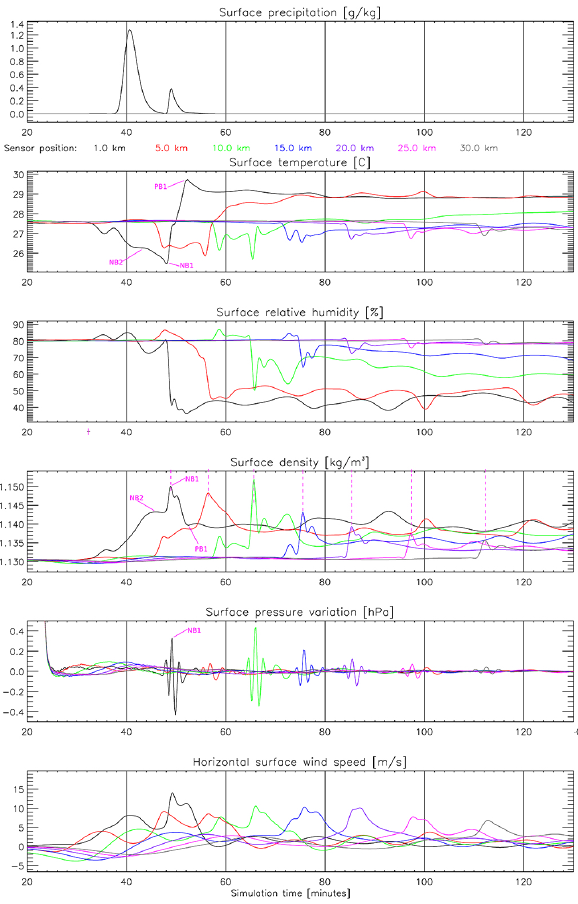
Fig. 4. Idealized benchmark simulation ( 0 = 3 . 5Kkm − 1 ). Time records of precipitation [gkg − 1 ], temperature [ ◦ C], relative humid- ity [%], density [kgm − 3 ], pressure variation [Pa] and horizontal U -wind speed [ms − 1 ] measured in the lowest atmospheric model level (between 0 and 150m altitude) and referred to as “surface level”. Variation is defined as the difference between observed value and the hydrostatically stable state, calculated by WRF. Line colors identify the different virtual detection stations, situated at a distance of 1km (station A, black), 5km (B, red), 10km (C, green), 15km (D, blue), 20km (E, dark purple), 25km (F, light purple) and 30km (G, gray) from domain